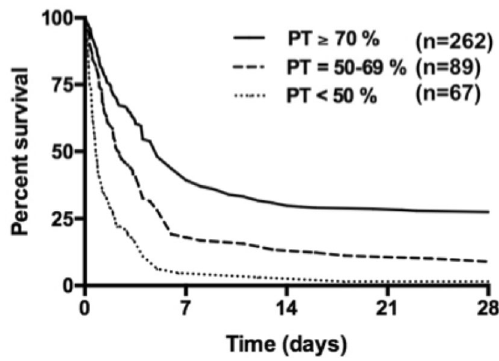
Fig. 1 Survival according to PT ratio at ICU admission F‑068 Using neuron‑specific‑enolase (NSE) for prediction of severe brain damage after cardiac arrest: insights from the Parisian